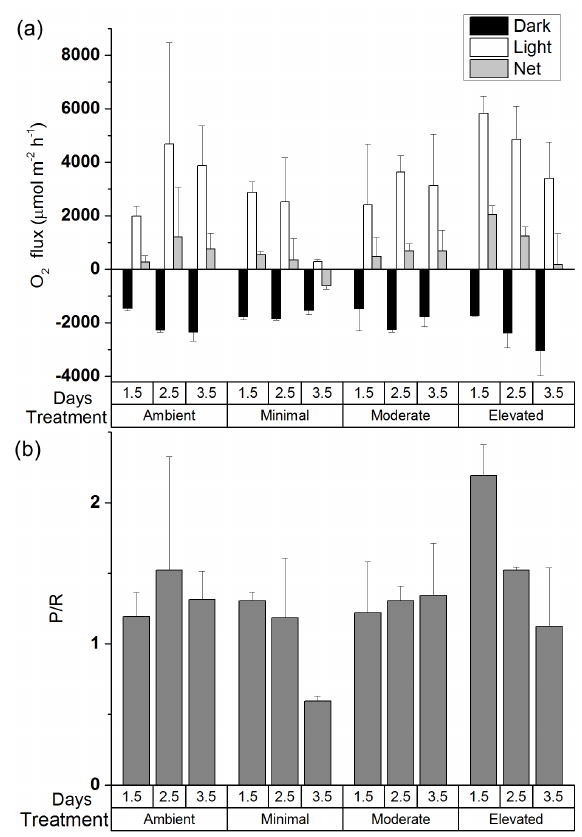
Figure 1. (a) Oxygen fluxes and (b) ratio of production to respira- tion (P/R) for all treatments across 24h calculated from oxygen fluxes for individual cores. Values are mean ±